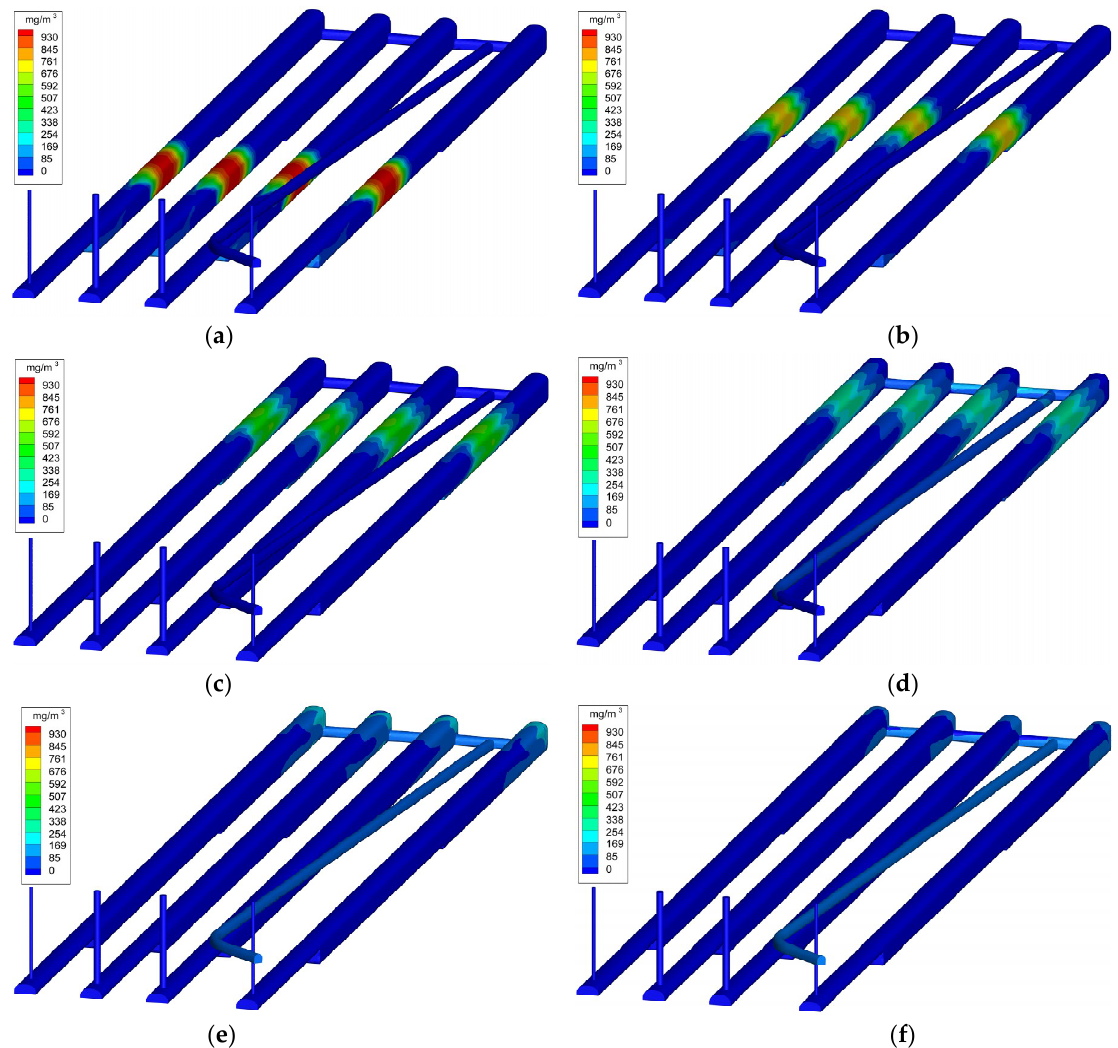
Figure 13. CO concentration distribution with time in caverns under the optimized ventilation scheme: ( a ) Ventilation for 5 min; ( b ) Ventilation for 10 min; ( c ) Ventilation for 15 min; ( d ) Ventilation for 20 min; ( e ) Ventilation for 25 min; ( f ) Ventilation for 30 min.